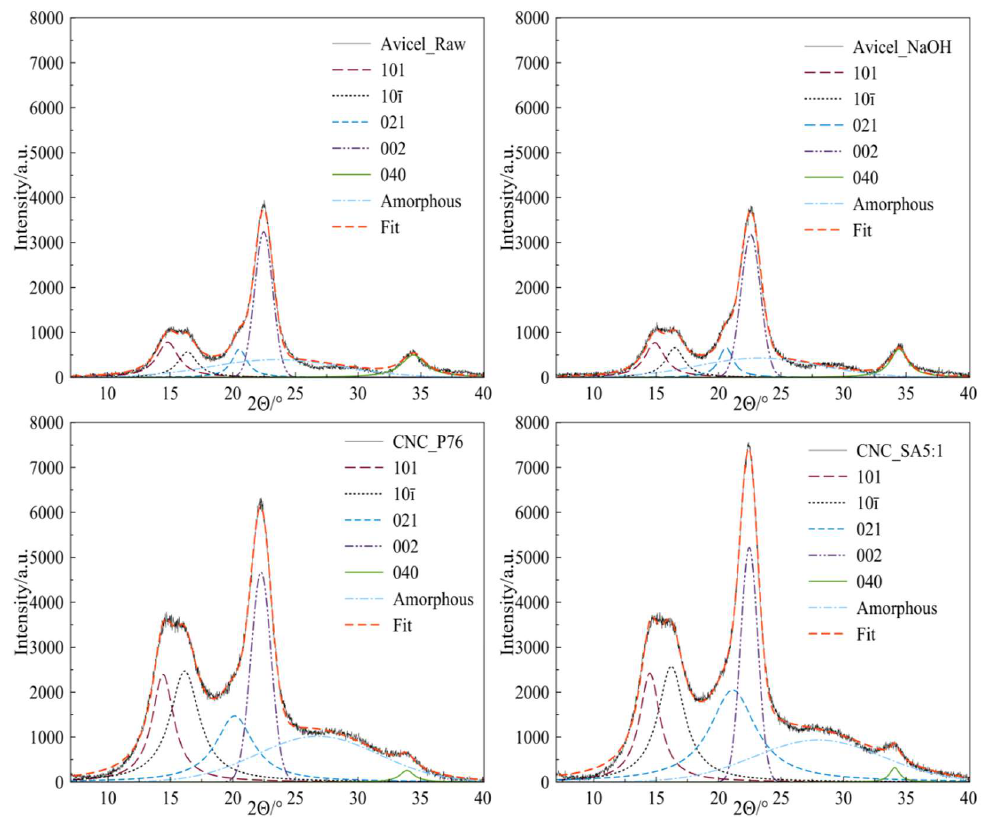
Figure 6. Representative deconvoluted WAXD patterns of raw Avicel, cellulose after alkali treatment, CNC obtained during hydrolysis in phosphoric acid solution (CNC_P76), and modified CNC (CNC_SA5:1).